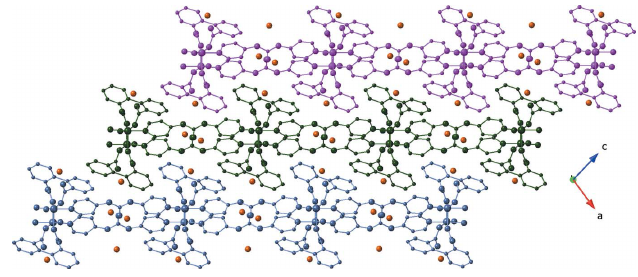
Figure 6 AAA stacking of [Cu(dip)(bpu)] n coordination polymer layer motifs in the title compound.